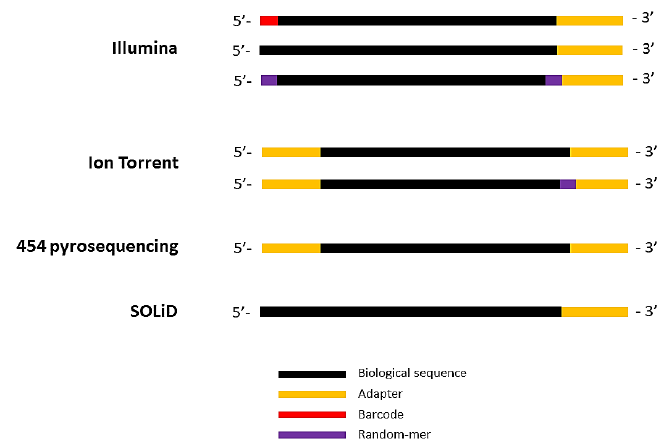
Figure 2. Schematic representation of output reads data format in different sequencing technologies. In all the four sequencing technologies, 3′ end adapters are ligated to biological sequences in the sequencing outputs; in addition, 5′ end adapters are present in Ion Torrent and 454 pyrosequencing outputs. The Illumina output reads may have four-letter barcode in the 5′ end, and/or random 4 “N” nucleotides at both ends. Similarly, depending on the library preparation kit used, output reads from Ion Torrent might have random 5-mer and a three-letter barcode in addition to 5′ end and 3′ end adapters.